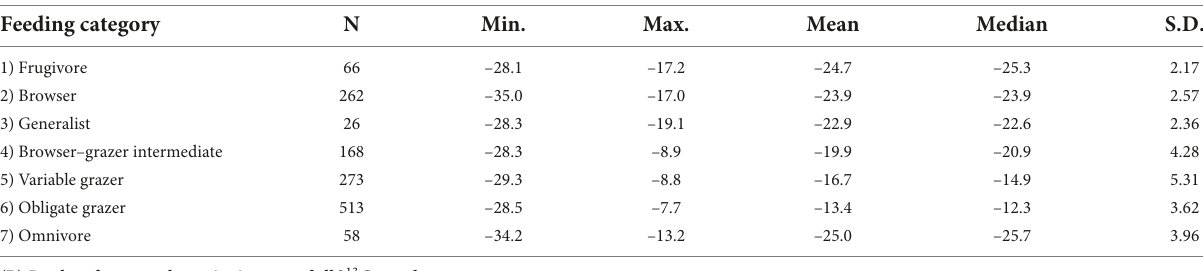
TABLE 3 Comparison of δ 13 C diet values among seven feeding categories of artiodactyls. (A) Summary statistics of all δ 13 C diet